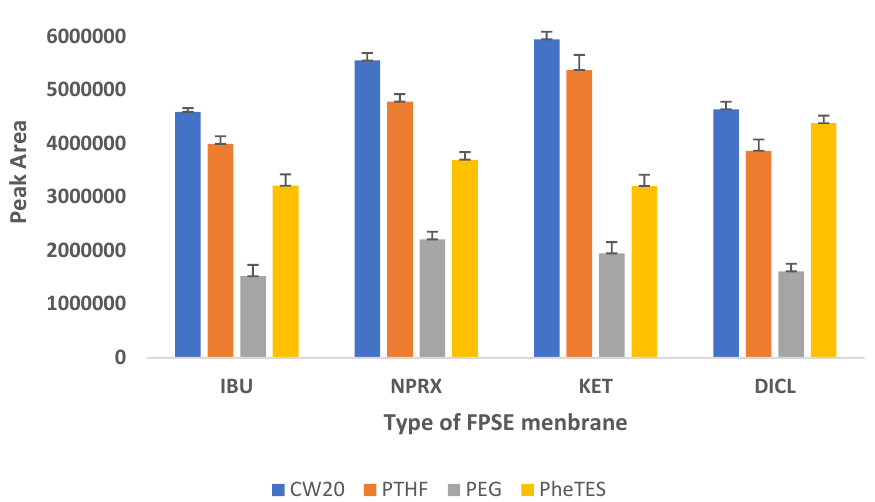
Figure 1. Screening of different FPSE membranes for NSAIDs.